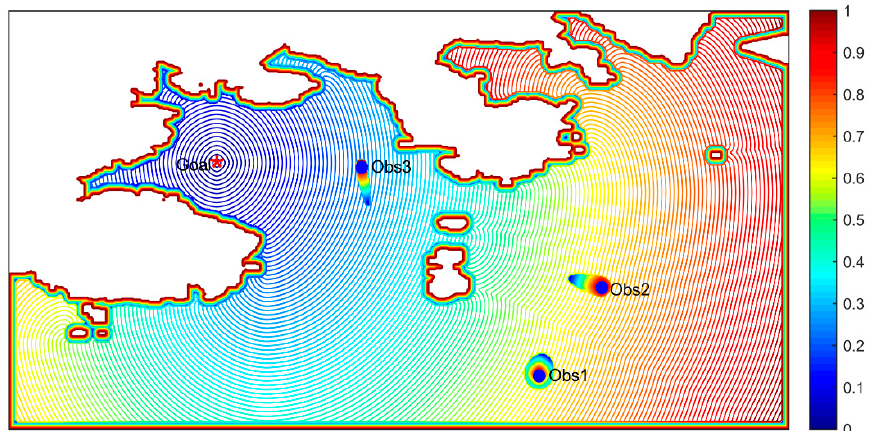
Figure 15. Final environmental potential field M total